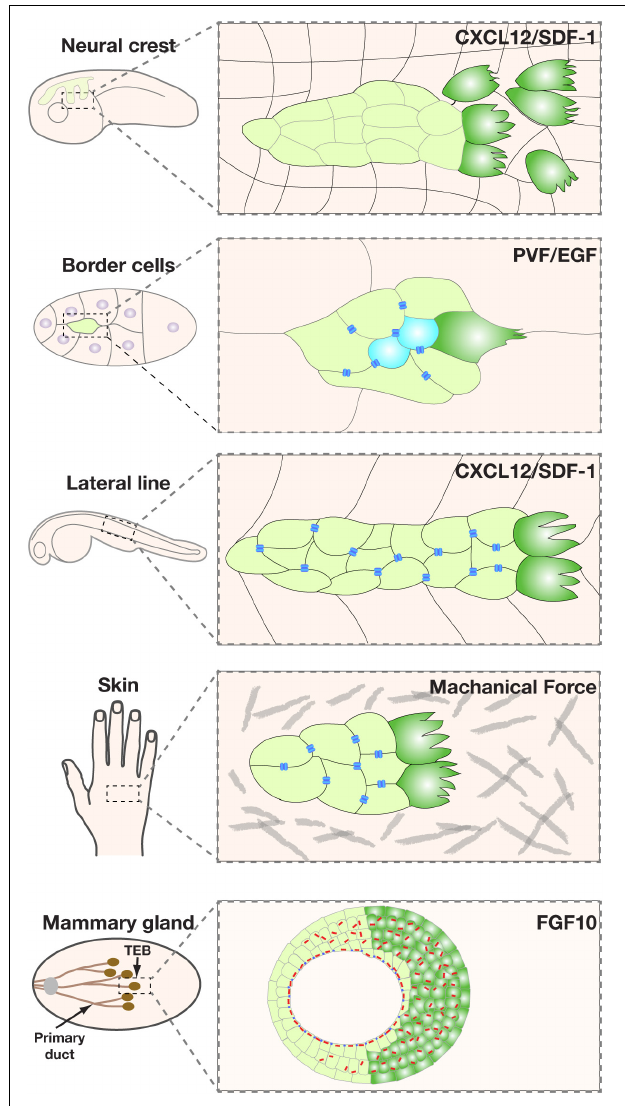
FIGURE 3 | Representative models of collective migration. Front-rear polarity in most of these models, including the Xenopus neural crest, Drosophila border cells, zebrafish lateral line, and mouse mammary gland, is triggered by a chemoattractant indicated, except for the wound healing model (using human skin as an example), where the external cue is thought to be mechanical forces. Leader cells are colored in green. Blue bars indicate the boundary of the apical and basolateral domains, which in vertebrates is where tight junctions locate, and in invertebrates is the subapical complex. They denote the presence of apicobasal polarity and the epithelial state. Note that neural crest cells do not have the blue bars because they are thought to have undergone a complete EMT and have lost the apicobasal polarity. Leader cells are colored in